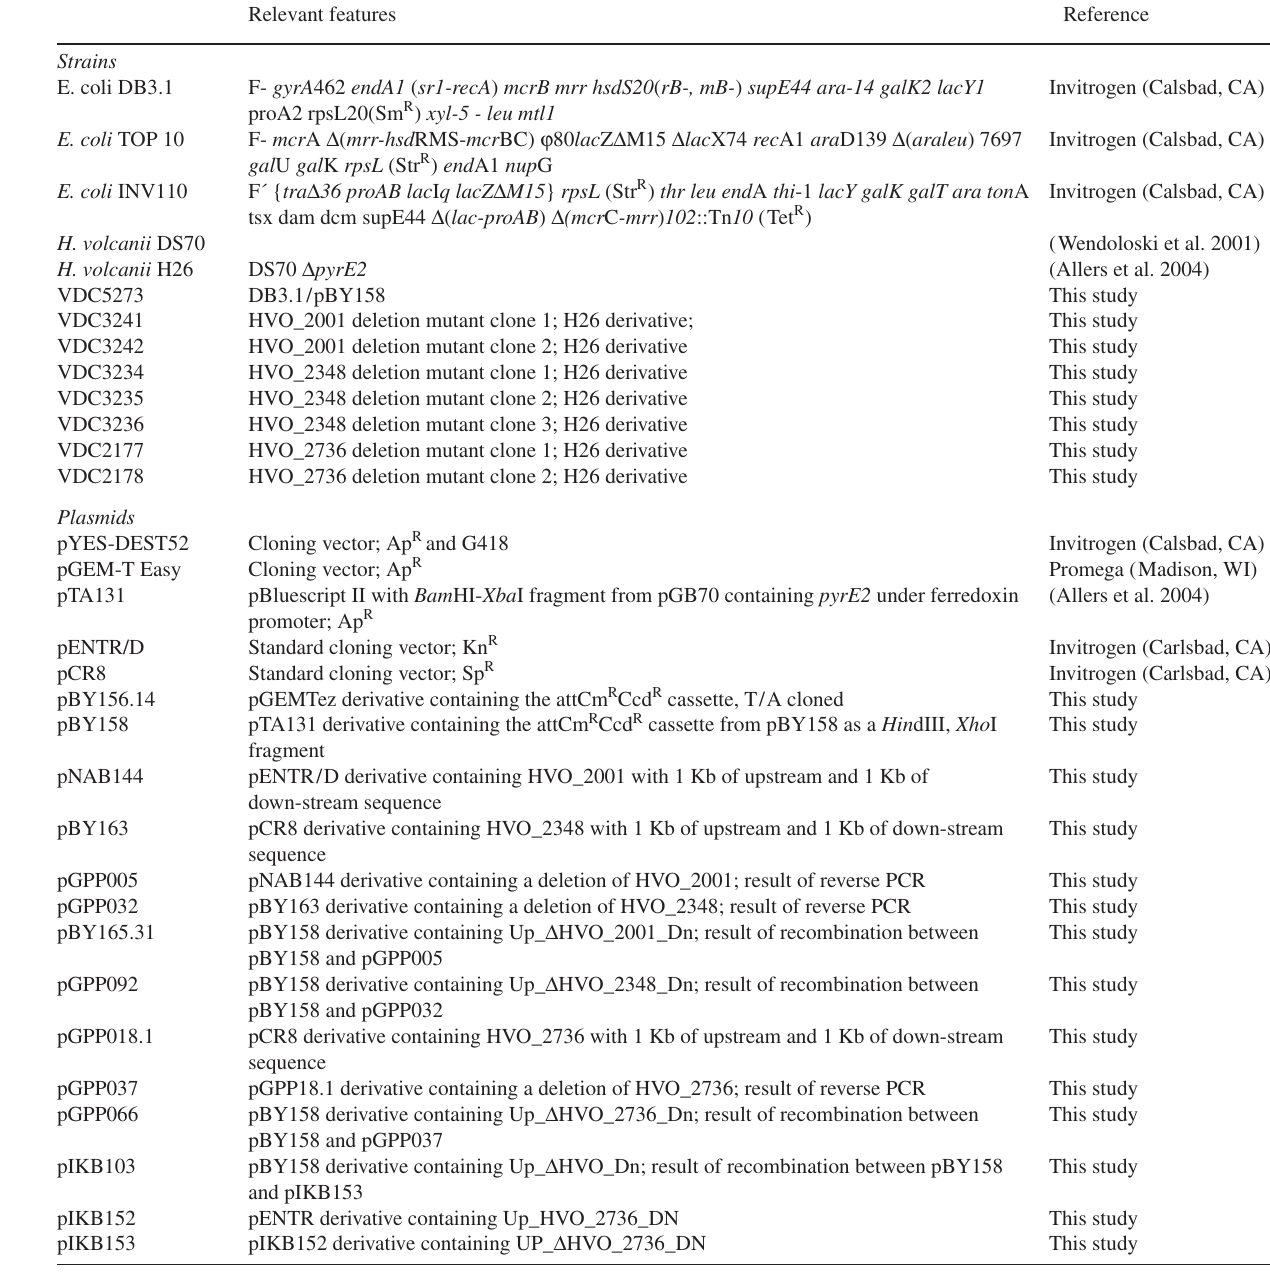
Table 1. List of strains and plasmids used in this